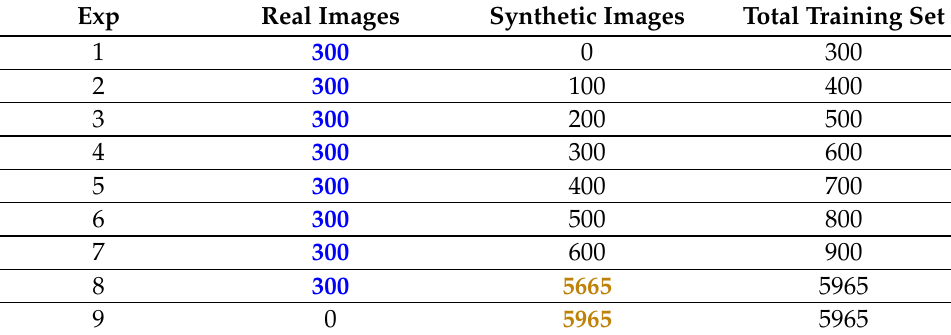
Table 1. Experimental training set